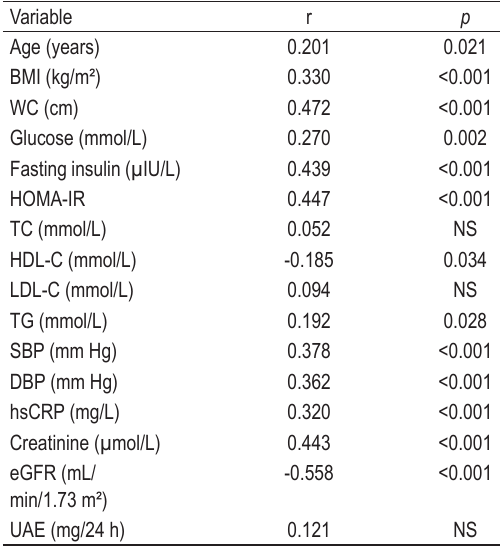
TABLE 2. Correlations of serum cystatin C level and studied parameters in all participants